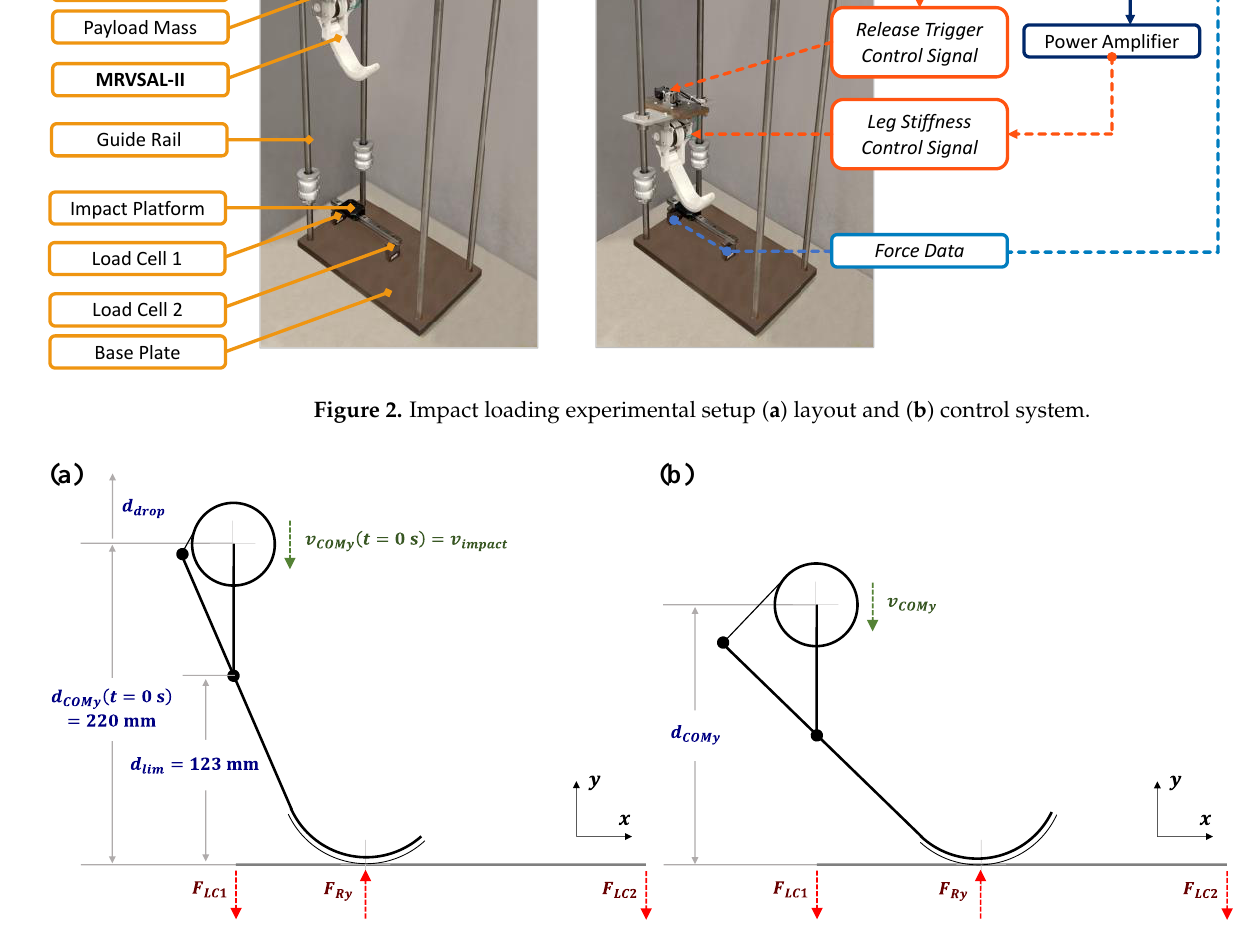
Figure 3. Impact loading free body diagram at ( a ) the moment of impact and ( b ) during impact.